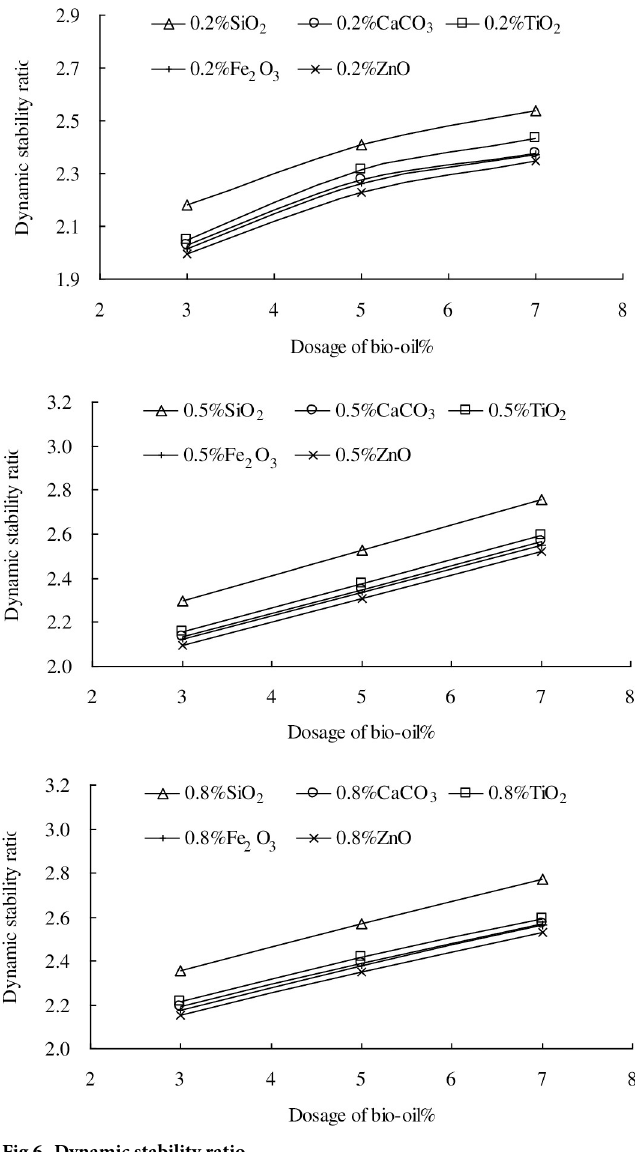
Fig 6. Dynamic stability